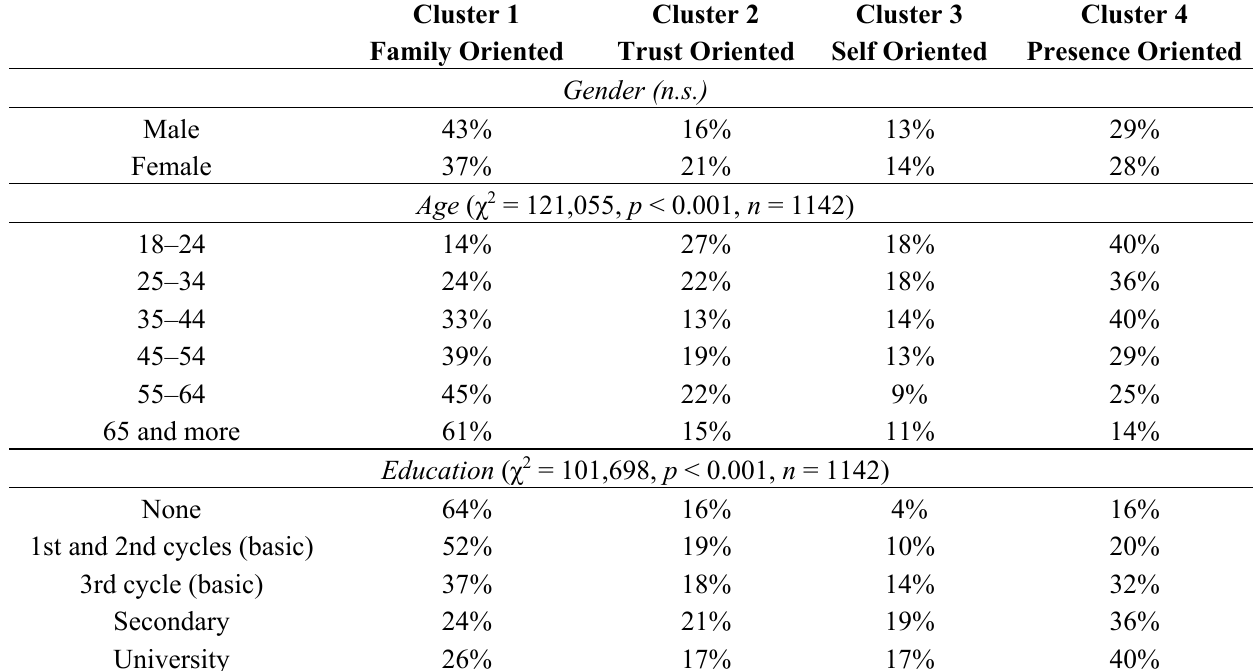
Table 1. Belonging to type of friendship representations (cluster membership), by structural predictors